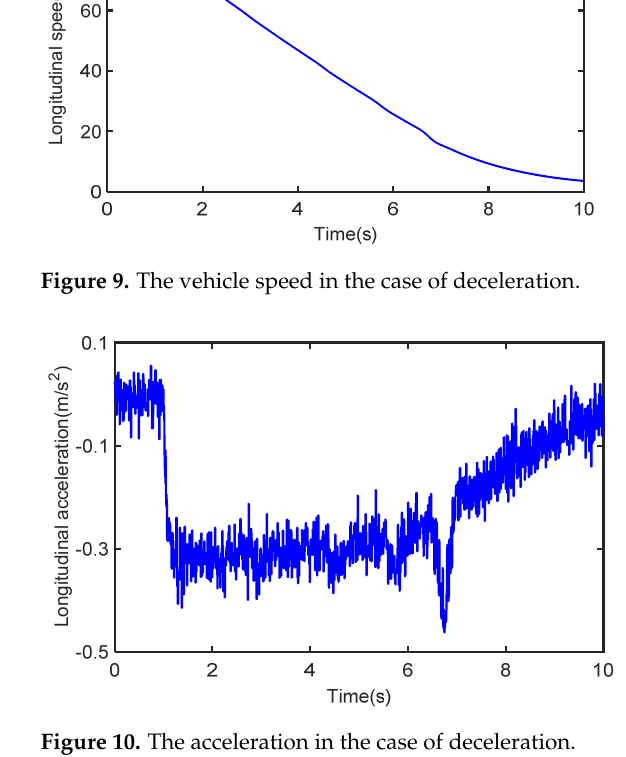
Figure 11. The tire forces in the case of deceleration. The results of the different methods used to estimate the mass are presented in Figure 12. The curves slowly rise from 800 Kg in the first 1 s, and with the addition of braking, the curves start to rapidly rise to track the reference value. However, it can also be seen that for the CKF at the beginning the rise is fast but the final stable value is much larger